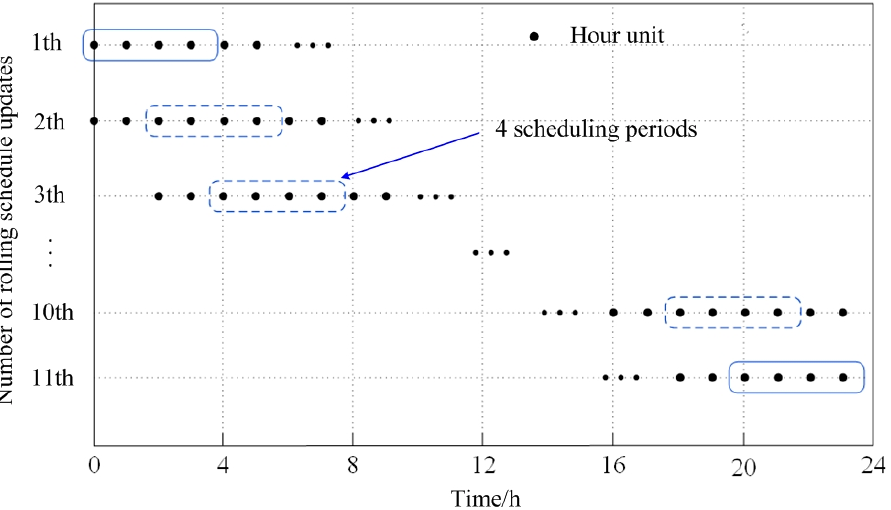
Figure 2. Schematic diagram of rolling planning time window.